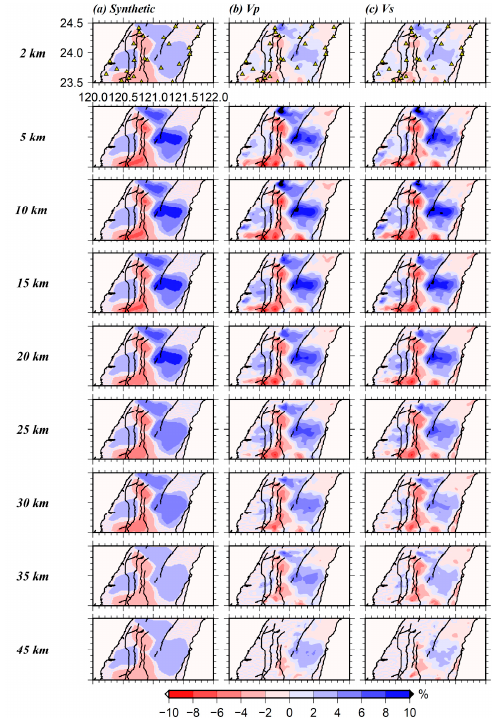
Figure 6. ( a ) A synthetic model with realistic configurations of anomalies. ( b ) Period II synthetic model of Vp. ( c ) Period II synthetic model of Vs. See the detail description in the text.